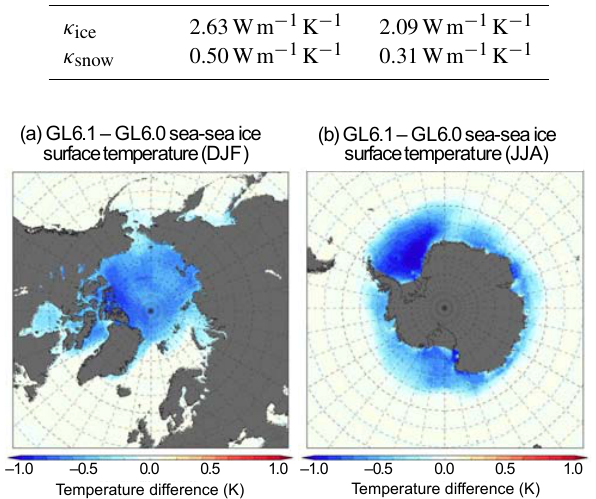
Figure 8. The difference in mean day 1 surface temperature over sea ice between GL6.1 and GL6.0 in sets of 12 N320-resolution forecast case studies run from operational ECMWF analyses in (a) December-January-February 2010/11 and 2011/12 (DJF) and (b) June-July-August 2011 and 2012 (JJA).